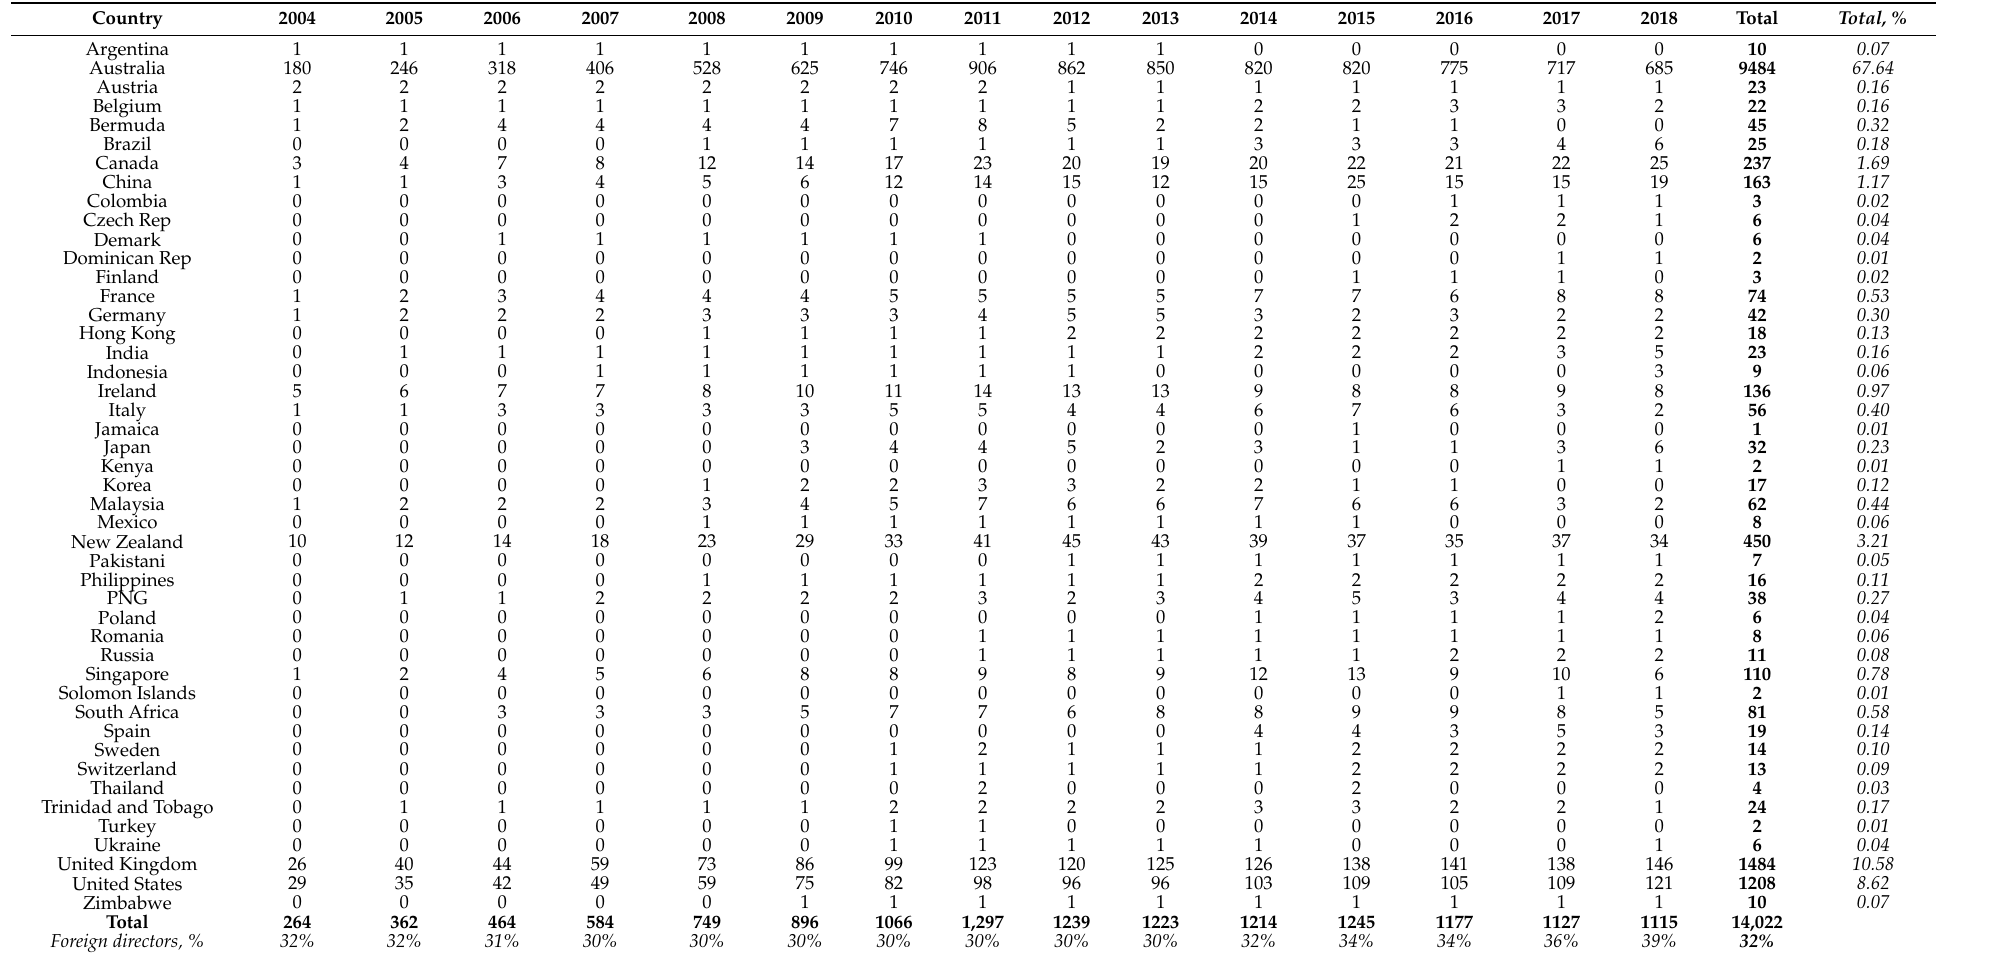
Table A3. Number of directors from each country by